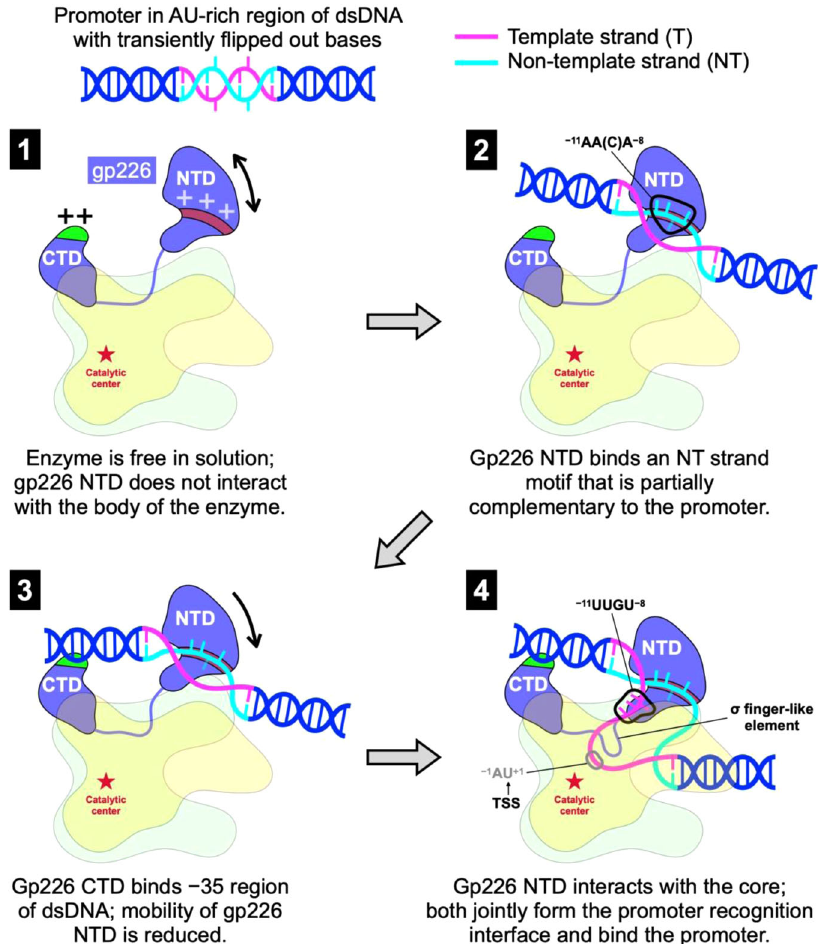
Fig. 10 The mechanism of template strand promoter recognition in dsDNA. For clarity, both proteins comprising the N- and C-terminal parts of the β and β ′ subunits are shown in the same color (light yellow for β and light green for β ′ ). Nucleotide bases are displayed as short sticks. The putatively degenerate, third position base − 9 C of the promoter-complementary motif − 11 AA(C)A − 8 is shown as a semitransparent stick. The ‘ + ’ signs indicate positively charged elements of the gp226 NTD and CTD molecular surface that participate in DNA binding. See the main text for full